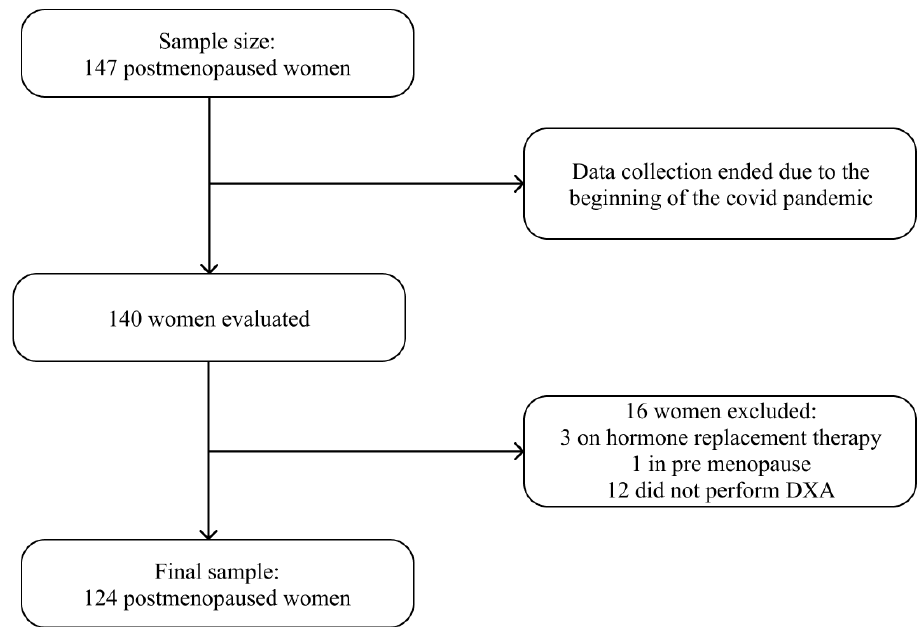
Figure 1. Sample selection flowchart.